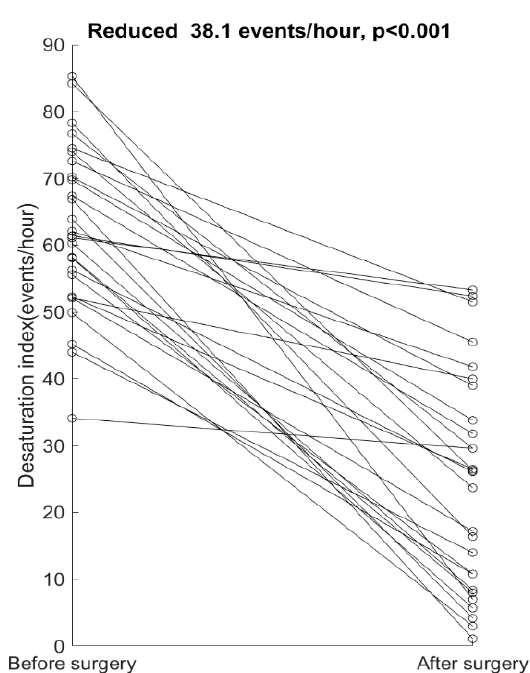
Figure 5. Individual change of desaturation index. After the surgery, the mean desaturation frequency cut 38.1 events/h, p < 0.001.